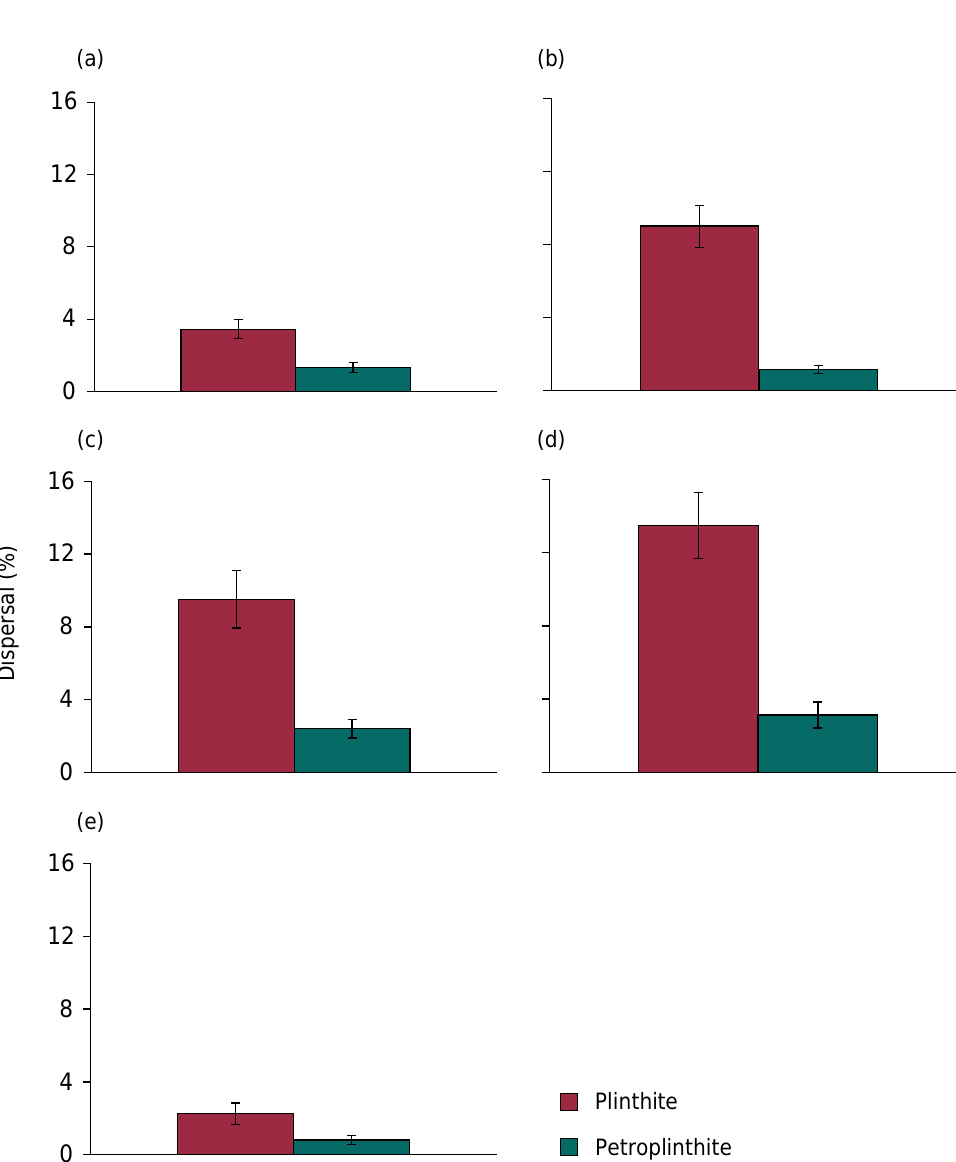
Figure 1. Mean value and standard error of the mean plinthite and petroplinthite dispersion of the studied profiles, immersed in distilled water (a), calcium carbonate (b), sodium hydroxide (c), sodium hydroxide + sodium hexametaphosphate (d), and acid solution (e) (95 % confidence interval;